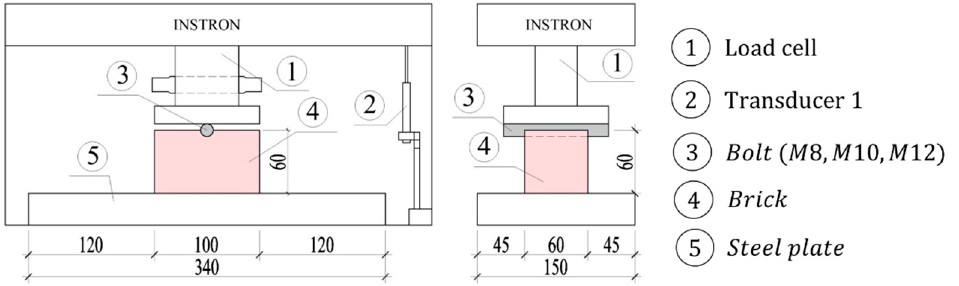
Figure 4. Schematic setup of the dowel-bearing test.